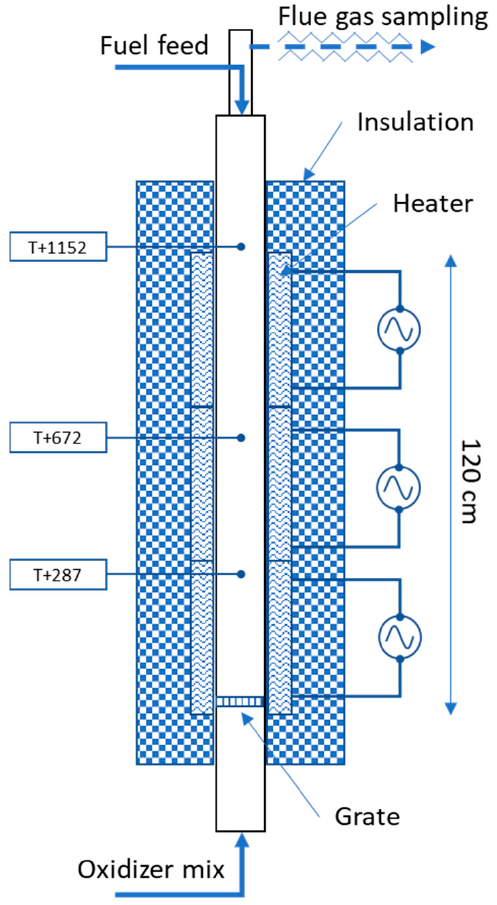
Figure 1. Sketch of the vertical tube furnace (VTF) reactor showing the three independently regulated heating zones, streams in and out, the grate, and the thermocouples locations (in mm over the grate).